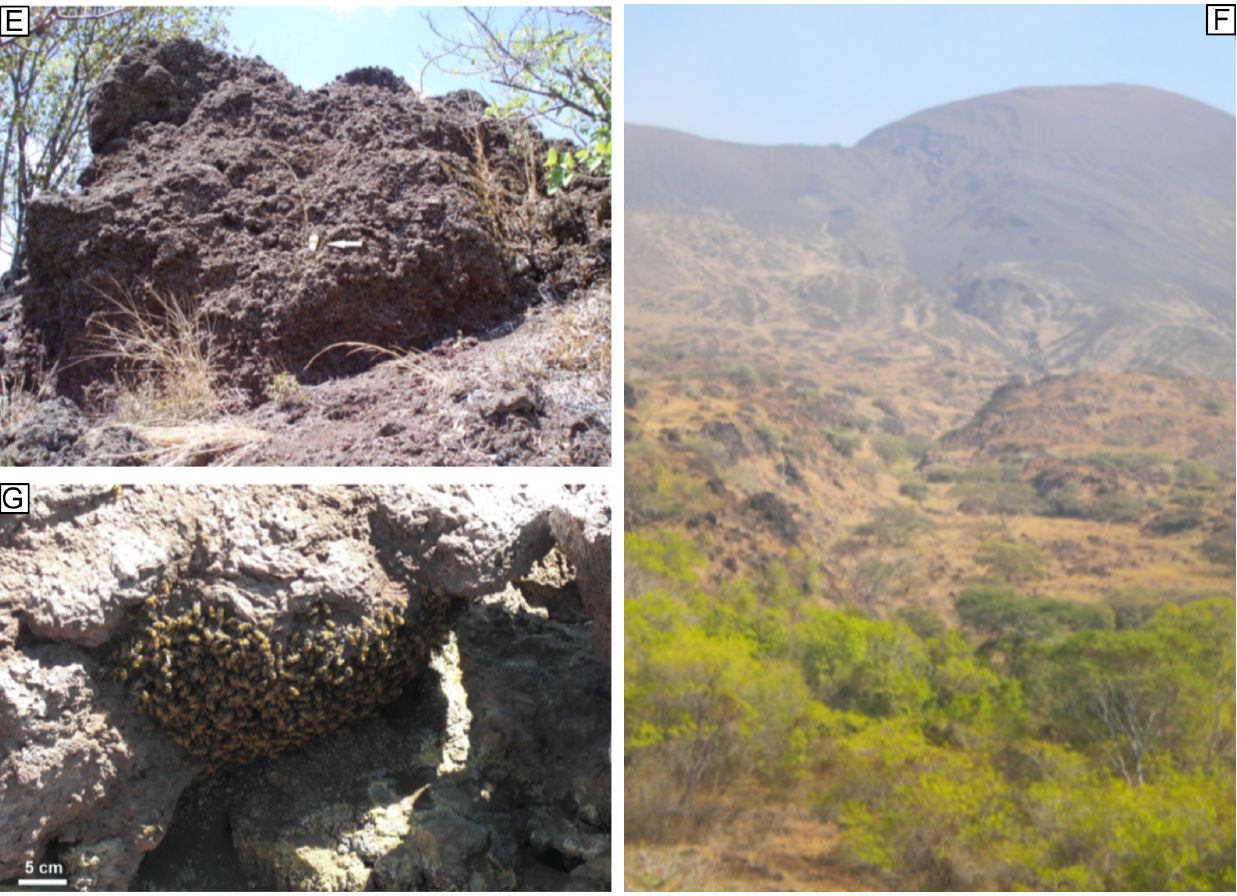
Figure 3: [cont.]: [E] spatter rampart (SC1); [F] fissure in San Pedro (LF1); [G] fumarole in Nindiri covered by bees attracted by the moisture